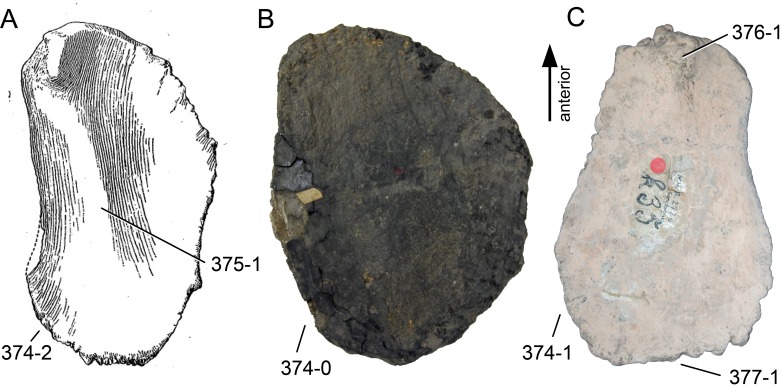
Neosauropod sternal plates.Right (A, B) and left (C) sternal plates of Giraffatitan brancai MB.R.2181 (A; modified from Janensch, 1961), Brontosaurus amplus YPM 1981 (B), and Tornieria africana MB.R.2726 (C) in ventral view. Note the different shapes (oval, B, C374-0; triangular, C, C374-1; crescentic, A, C374-2), the longitudinal ridge (A; C375-1), the anterior dorsoventral thickening (C; C376-1), and the straight posterior border (C; C377-1). Scaled to same length.